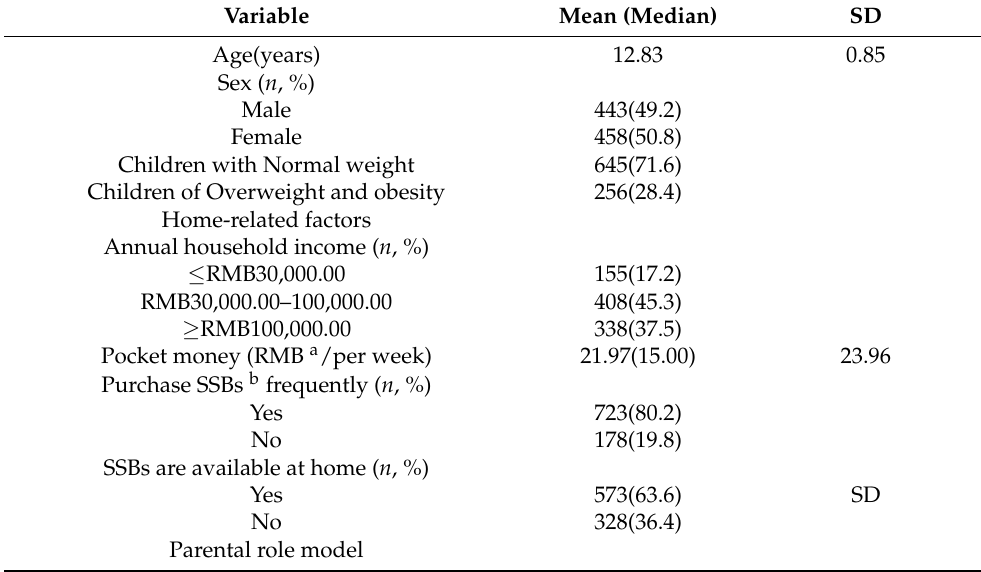
Table 2. Child participants characteristics ( n =